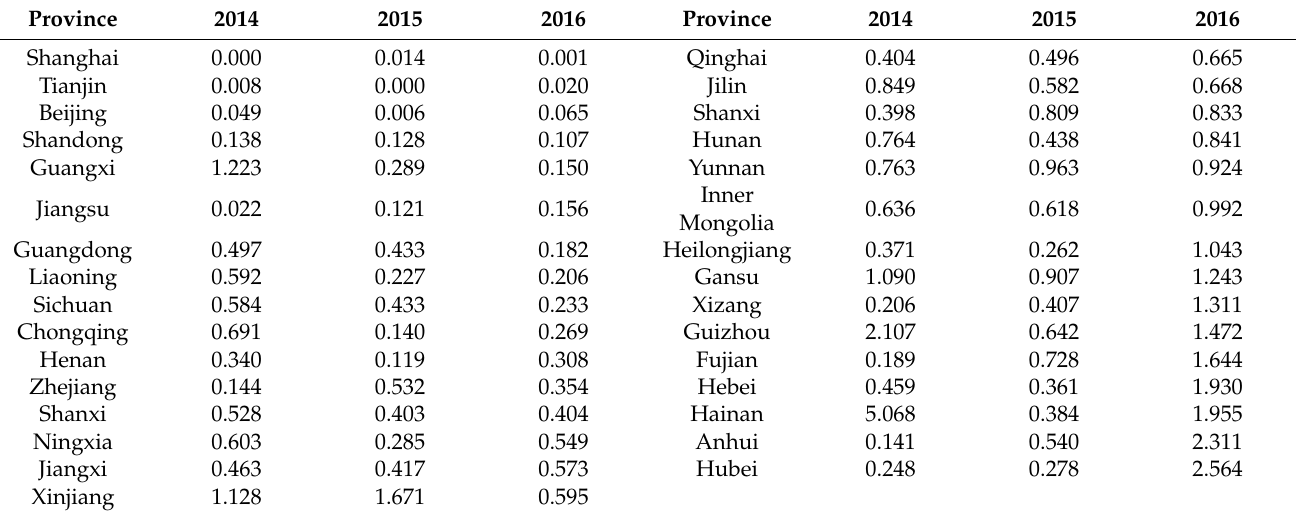
Table 1. Climate shock index by province